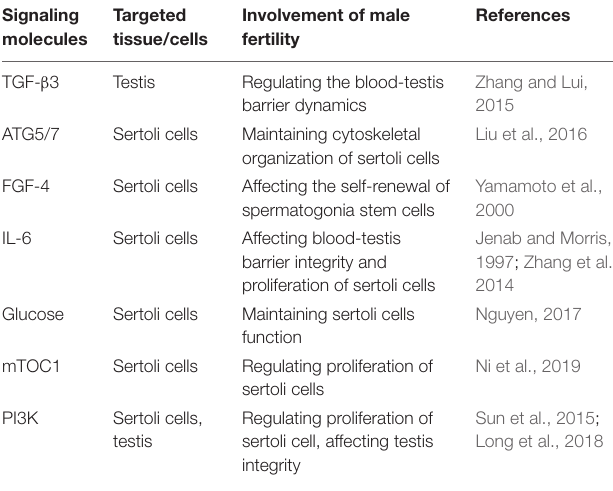
TABLE 2 | Key signaling molecules associated with oxidative stress-autophagy axis and their effect on male